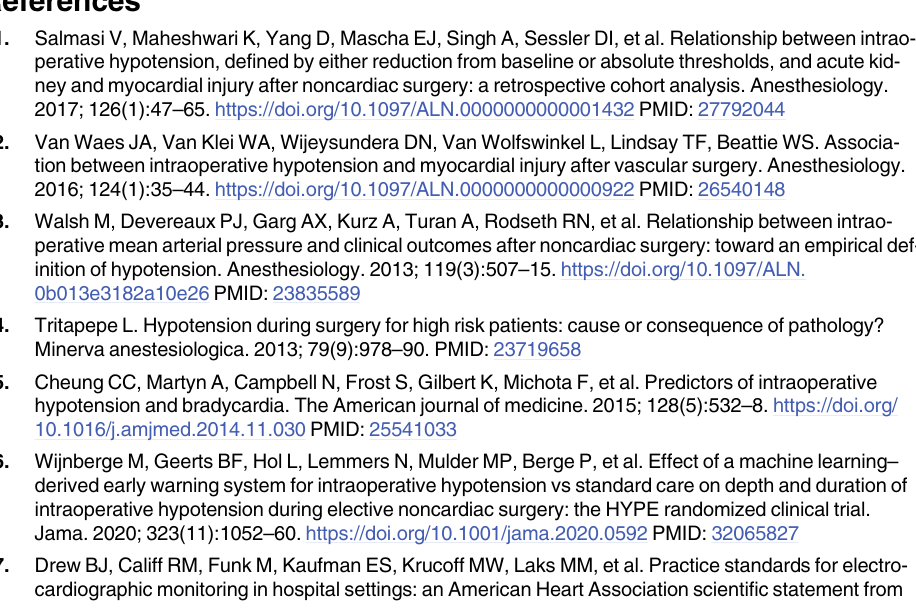
S4 Table. The model performance on consecutively sampled waveforms with 1-minute interval over the entire surgical procedures in 100 randomly selected cases. S5 Table. Comparison of test dataset between the main and post hoc analysis. S6 Table. Post hoc analysis: Statistical significance of comparison of models using different combinations of waveforms. P-values were calculated with DeLong’s method and corrected using Bonferroni’s